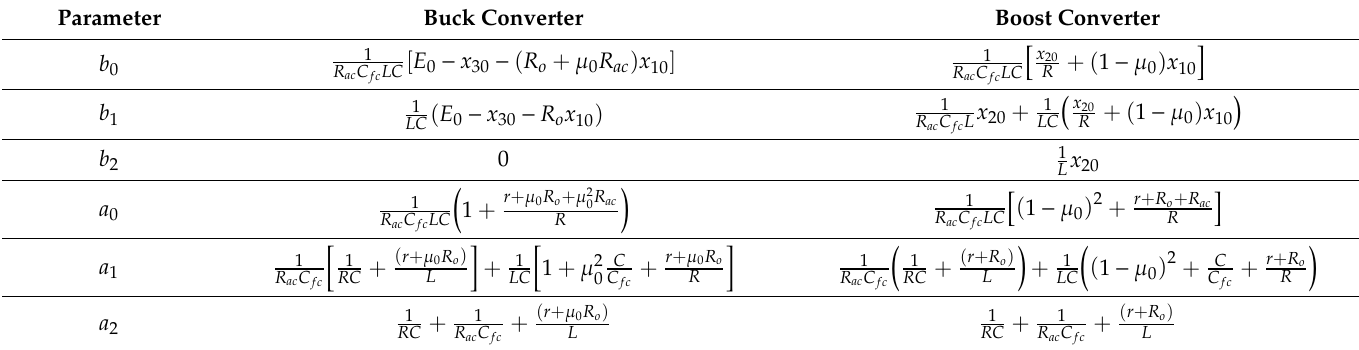
Table 1. Parameters involved in